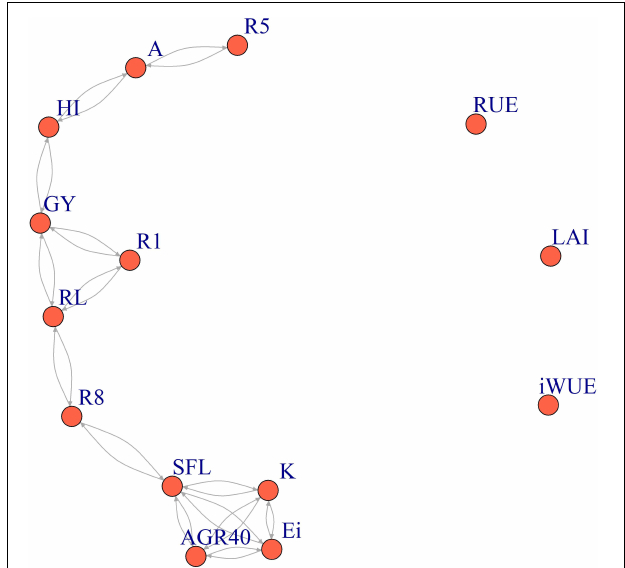
FIGURE 2 | Undirected model through the LASSO algorithm for additive–genetic relationship among physiological and phenological traits with light interception efficiency ( Ei ), radiation use efficiency ( RUE ), harvest index ( HI ), and grain yield ( GY ) in a maturity-controlled panel of soybean. Three hundred eighty-three recombinant inbred lines (RILs) evaluated in three environments. A , photosynthesis; AGR40 , average canopy coverage growth rate during the first 40 DAP ; K , light extinction coefficient; iWUE , intrinsic water use efficiency; LAI , leaf area index; R1 , days to flowering; R5 , days to beginning of seed formation; R8 , days to maturity; RL , reproductive period length; SFL , seed-filling length; LASSO, least absolute shrinkage and selection operator.